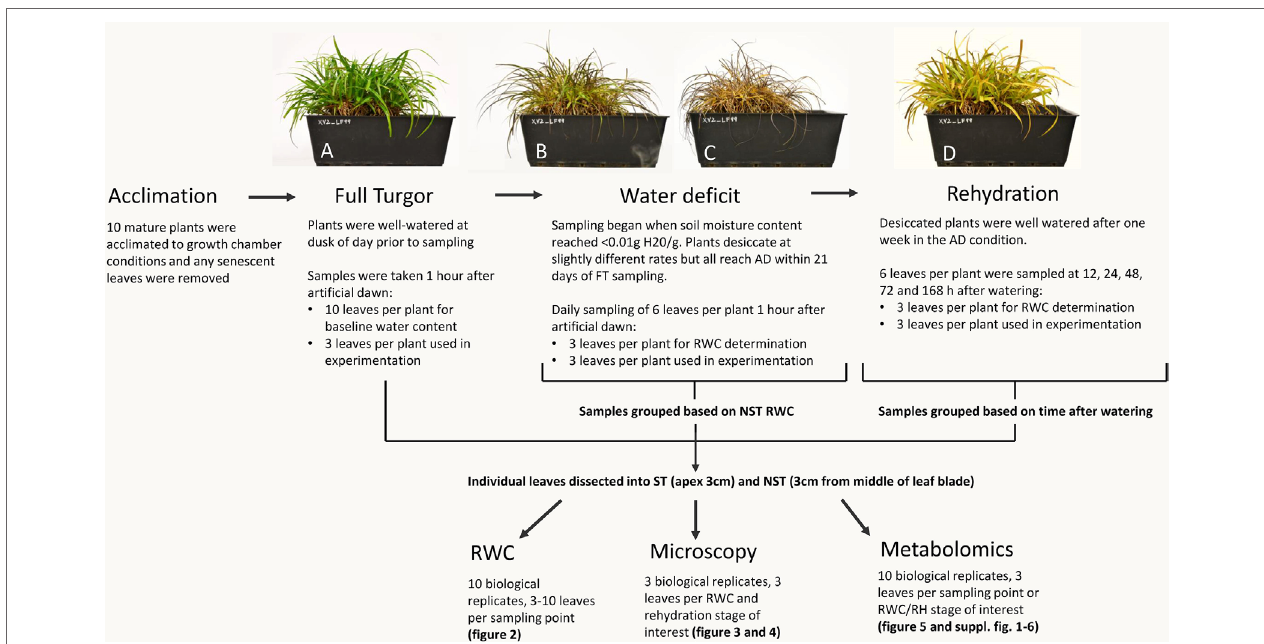
FigURe 1 | Sampling procedure for relative water content (RWC), microscopy, and metabolomics. Plants experiencing the same water deficit stress were sampled for multiple procedures. All 10 plants were utilized for water content determination (3–10 leaves per plant per sampling point) and metabolomics (3 leaves per plant per RWC/RH stage of interest), while microscopy was performed on three plants (3 leaves per plant per RWC/RH stage of interest). A typical experimental X. schlechteri is shown before, during, and after water deficit stress: FT (A) , 60% RWC (B) , AD (C) , and 48 h after rehydration (D) .